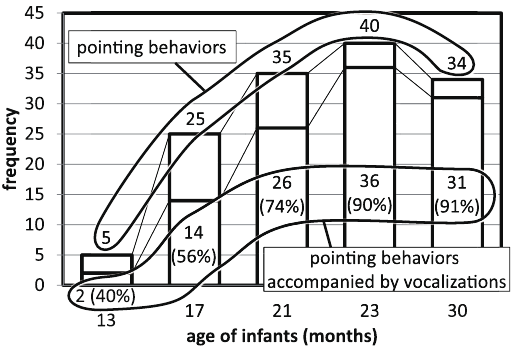
Fig. 2. Ratio of Pointing Behaviors with Vocalizations by Each Age (b): Empirical Research on Pointing Behaviors during Picture Book Reading (studied in Ref.